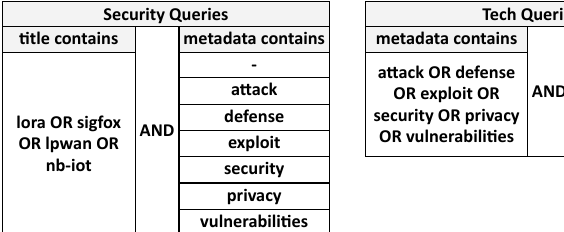
Figure 4. Queries defined for each category (“Security”, “Tech” and “Smart”).